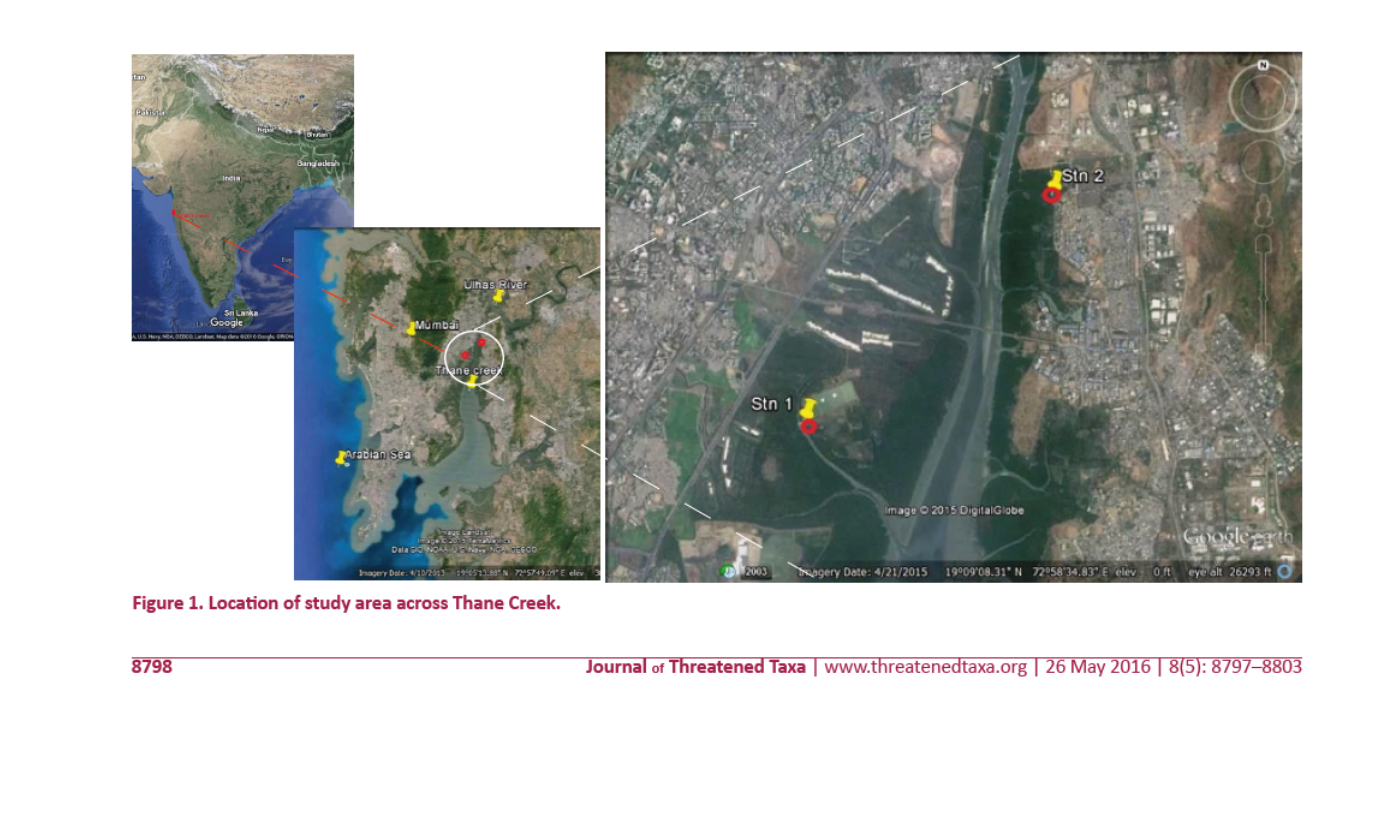
Ffigure 1. Locafion off study area across Thane